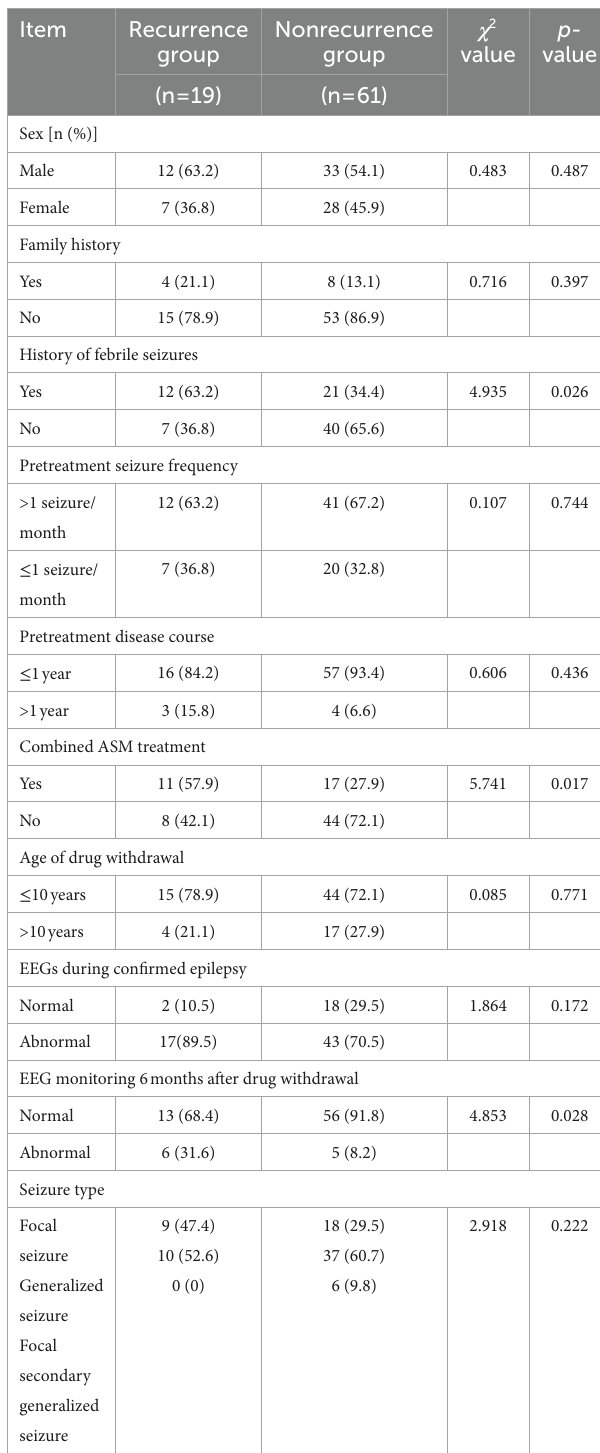
TABLE 2 Univariate analysis of pediatric epilepsy relapse 2 years after drug withdrawal.